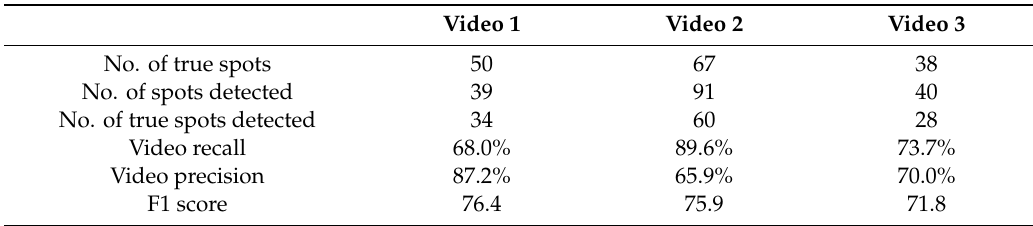
Table 4. Lesion statistics and metrics of Videos 1–3 using the custom DCNN system 1 . The videos are illustrated in Section 2.1.